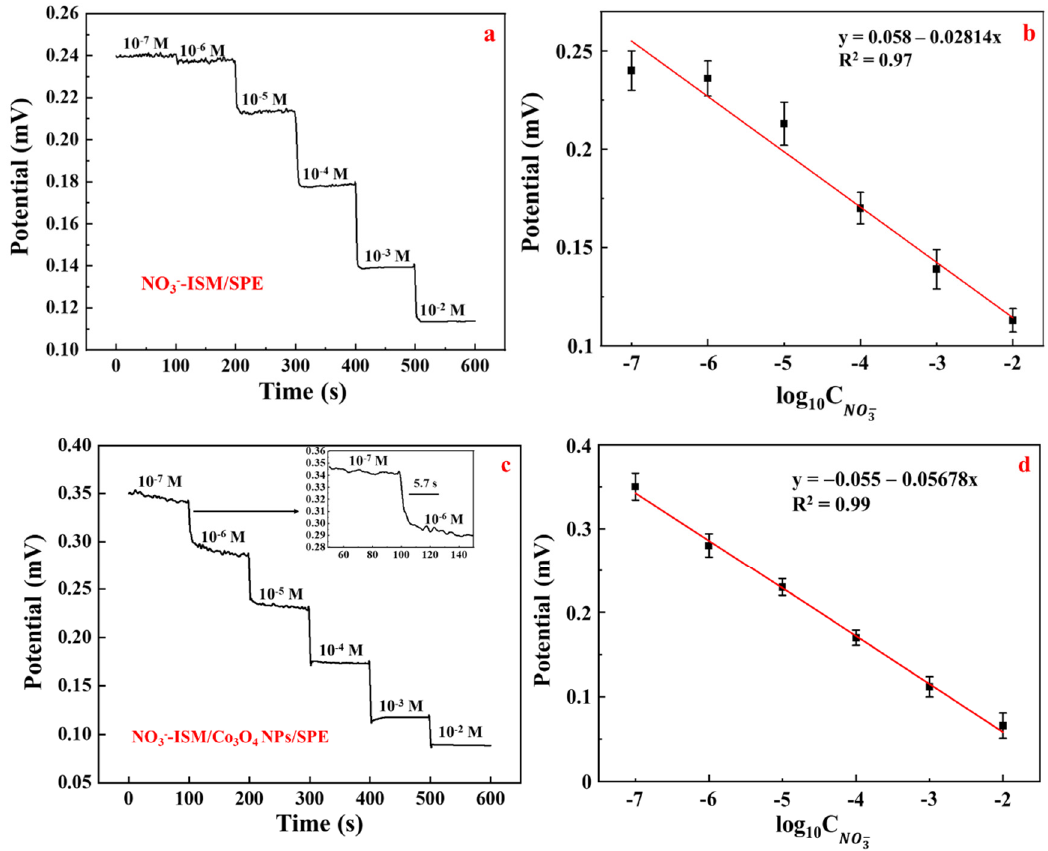
Figure 11. Dynamic potentiometric response and calibration curve for the NO 3 − -ISM/SPE ( a , b ) and the NO 3 − -ISM/Co 3 O 4 NPs/SPE ( c , d ).